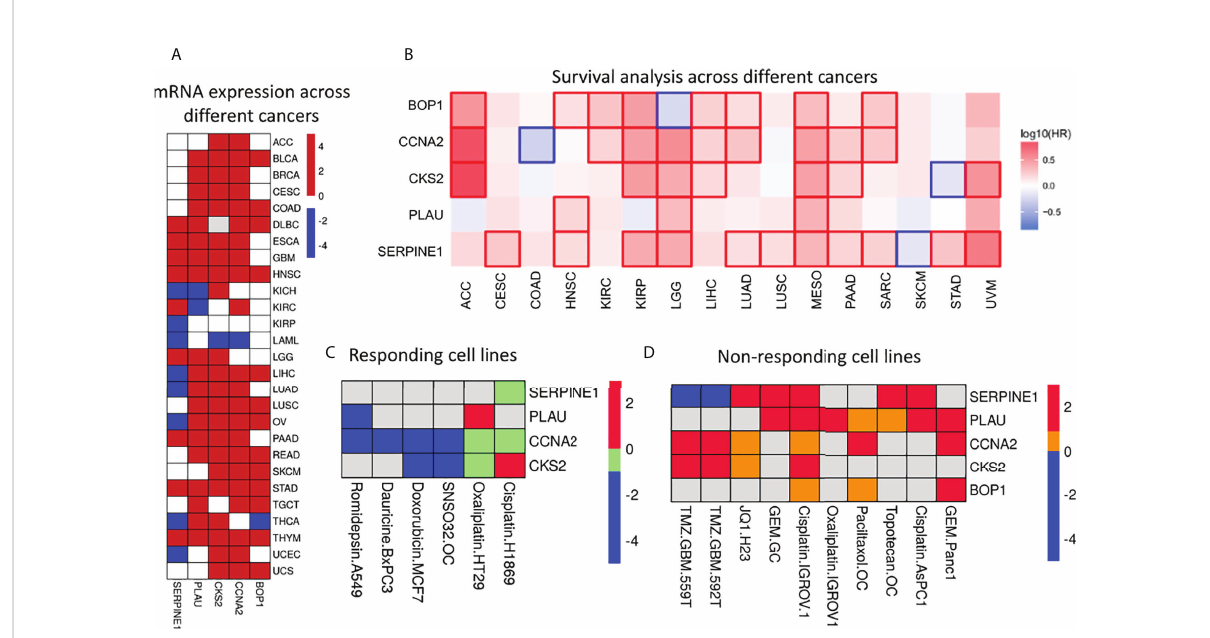
FIGURE 5 Expression & signi fi cance of selected prognostic genes. (A) Differential gene expression analysis across different cancers. Red, blue and white squares depict over, under and insigni fi cant expression respectively. It is clear that these genes are upregulated in most of the cancers. (B) Survival map: Red and blue squares indicate poor survival due to over and under expression respectively. The fi gure clearly indicates the expression of these genes have signi fi cant effect on survival of the patients across cancers. (C) Heatmap represents expression level of these genes in drug sensitive cells. These genes were found to be signi fi cantly differentially expressed (|log 2 Fc| > 1 and pvalue < 0.05). The down- (blue) and up- (red) regulated genes in response to drug; green square indicates down-regulated genes with signi fi cant pvalue but |log 2 Fc| < 1. Grey square indicated no differential expression. (D) The expression of selected genes in drug resistant cells. Red and blue squares indicate signi fi cant (|log 2 Fc| > 1 and pvalue < 0.05) up- and down-regulated genes; yellow square indicates up-regulated genes with signi fi cant pvalue (|log 2 Fc| < 1); grey square indicated no differential expression of the